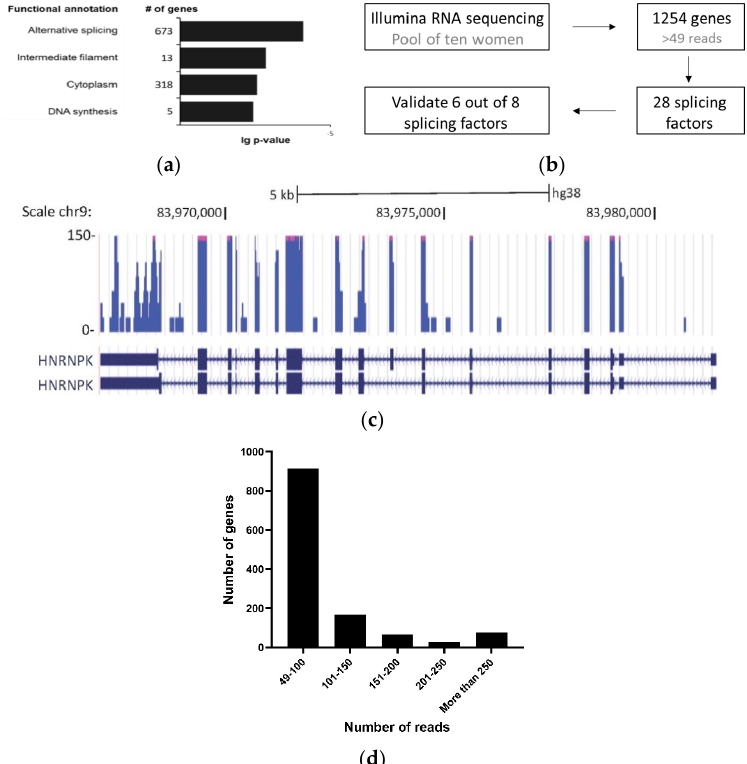
Figure 1. Enrichment of alternative splicing proteins in saliva cell-free RNA. The RNA-seq of cell-free RNA was extracted from the saliva of ten women. ( a ) Functional analysis of the 1254 transcripts identified was conducted using the DAVID functional annotation tool (DAVID, https://david.ncifcrf.gov/). ( b ) Schematic representation of the splicing factors chosen from the RNA-seq to use for the diagnostic test. ( c ) UCSC Genome Browser screen shot of RNA-seq data at the HNRNPK locus gene (reference genomeGRCh38/hg38). HNRNPK exon 8 alternative splicing was indicated by the RNA-seq results. ( d ) Transcript abundance in cell-free saliva represented by the number of genes relative to number of reads.